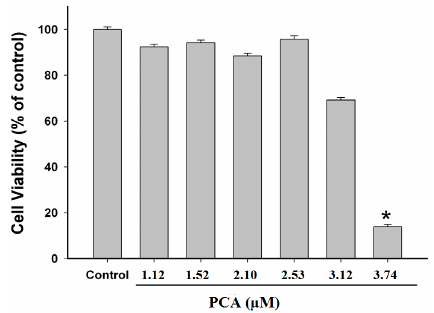
Figure 4. Effect of protocatechuic acid (PCA) on human gastric epithelial (GES-1) cell viability at different concentrations ranging from 1.12 to 3.74 µM. Values given are means ± S.E.M. of three independent measurements. * p < 0.05, indicates significant different compared with the control group.